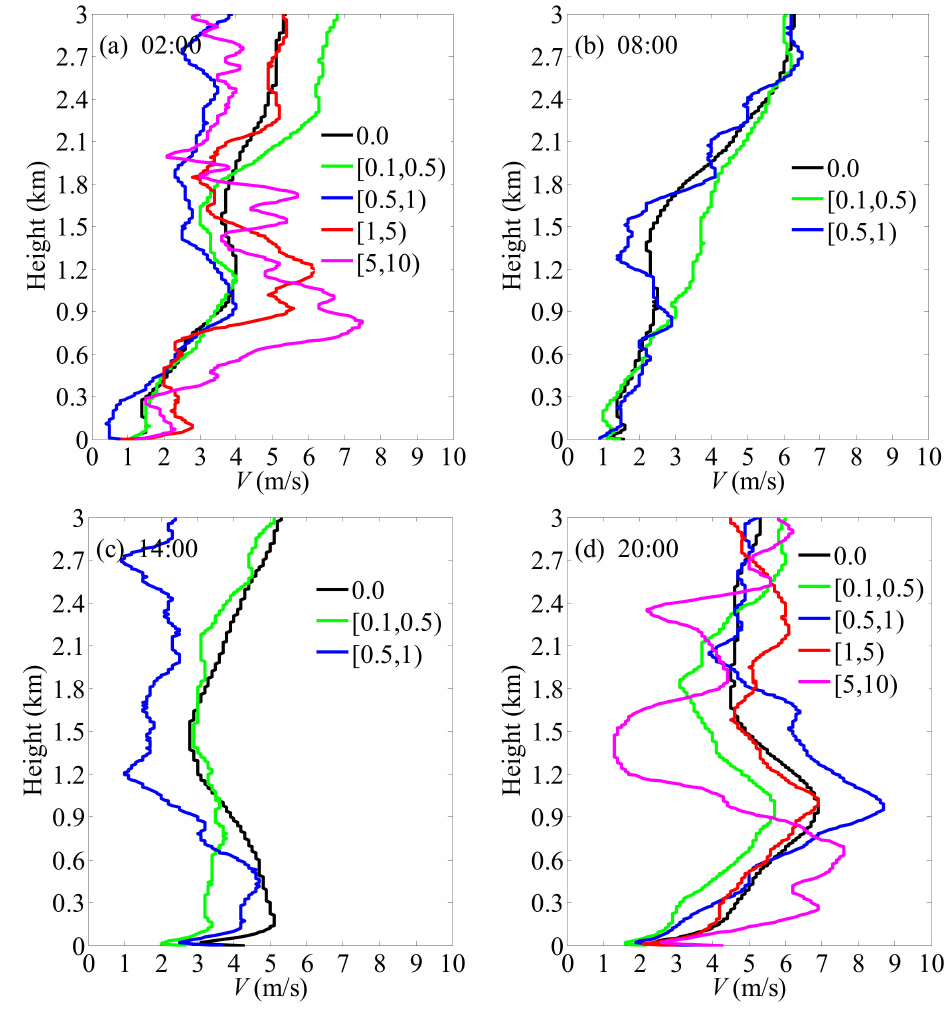
Figure 6. Atmospheric horizontal wind speed profiles in different precipitation grades at launch times in Jiulong from 2013–2020. ( a ) 02 LST, ( b ) 08 LST, ( c ) 14 LST and ( d ) 20 LST.